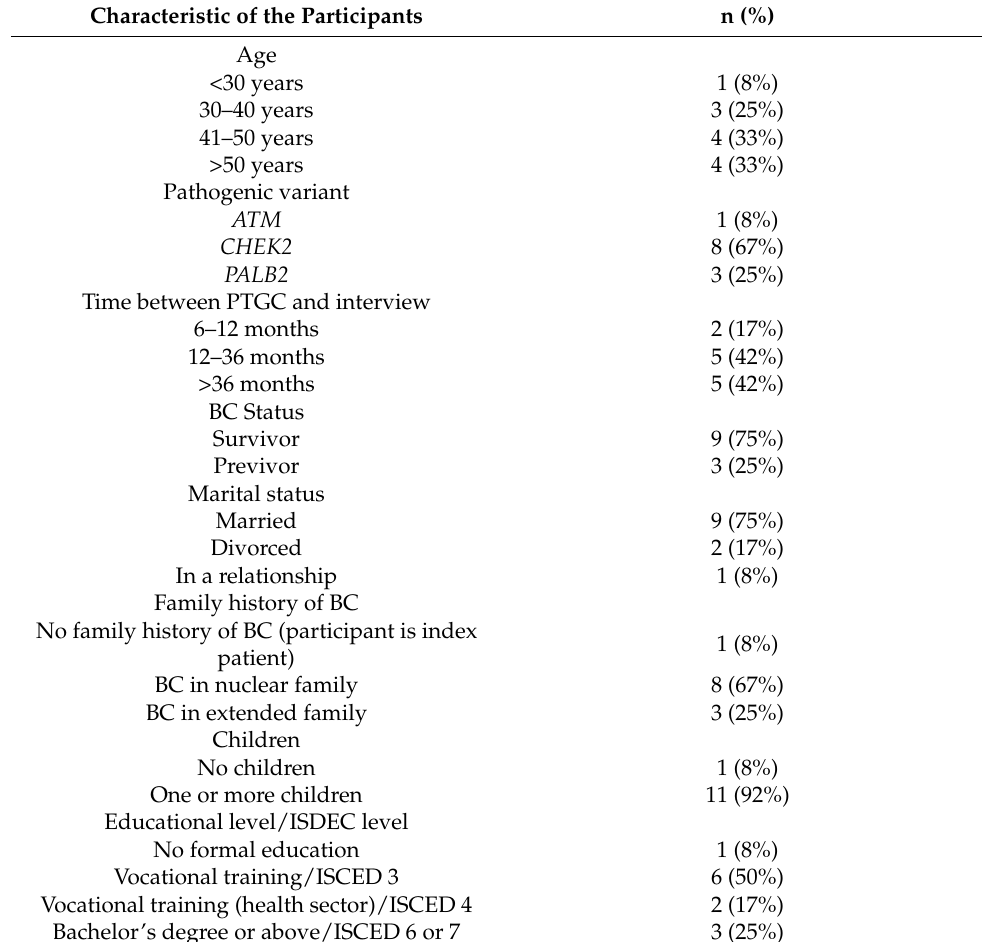
Table 1. Participant characteristics (n =